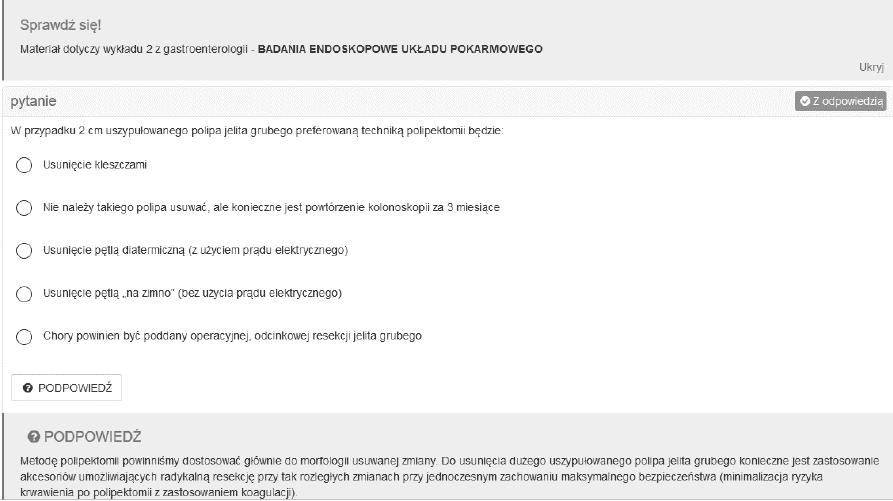
Figure 4. Self-test question as a follow-up to an e-learning lecture in Gastro- enterology for year 5 students of Medicine, with an example teacher’s hint given before